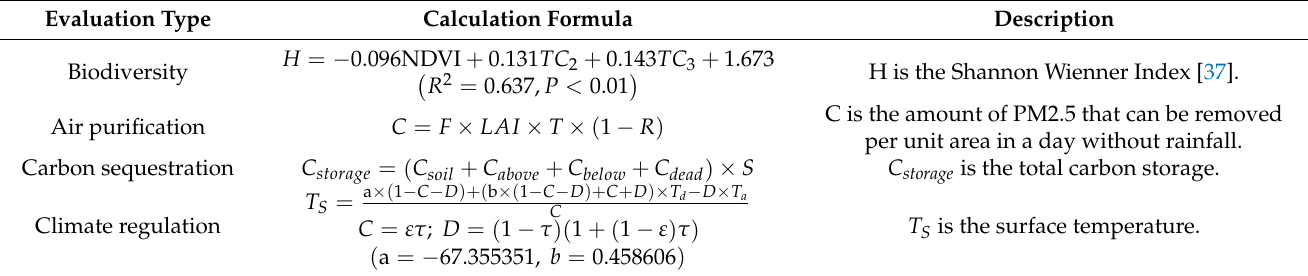
Table 1. Indexes and methods for estimating ecosystem service